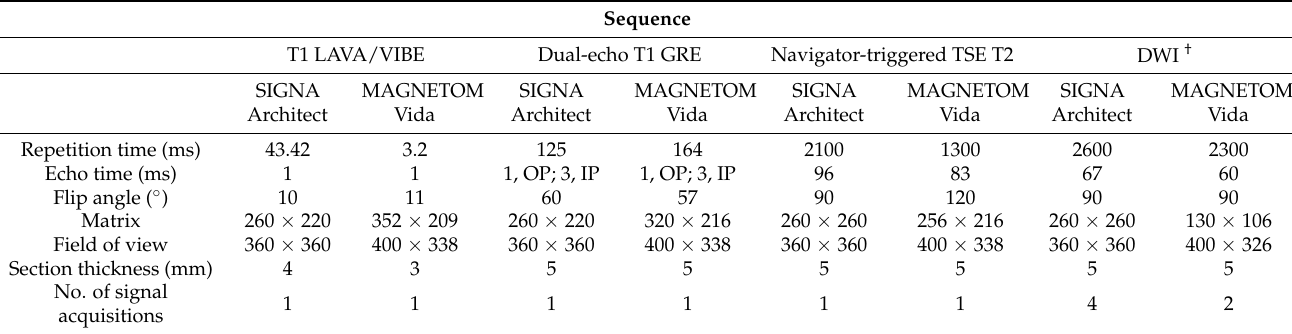
Table A1. Parameters of the MRI